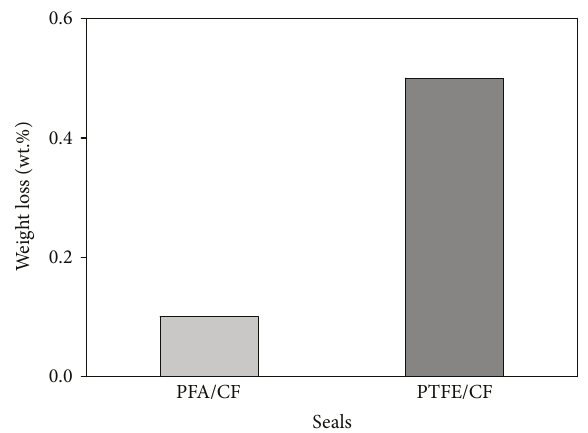
Figure 7: The weight loss of PTFE and PFA seal wear after test rigs.